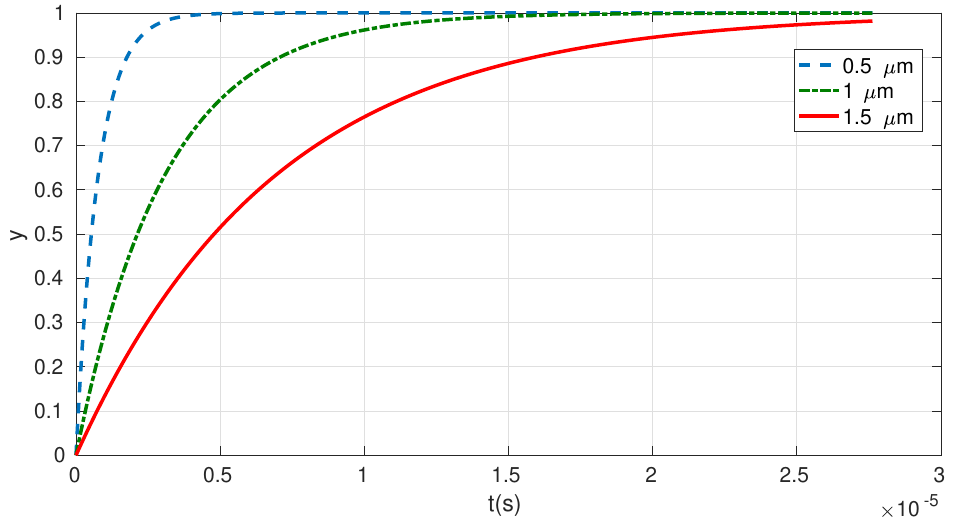
Figure 2. The temporal progress of the fractional velocity, y = u p / u ∗ ( u ∗ = 10 m/s), gain for aerosol particles of different dimensions dragged by the protecting air flow at Stocks regime.